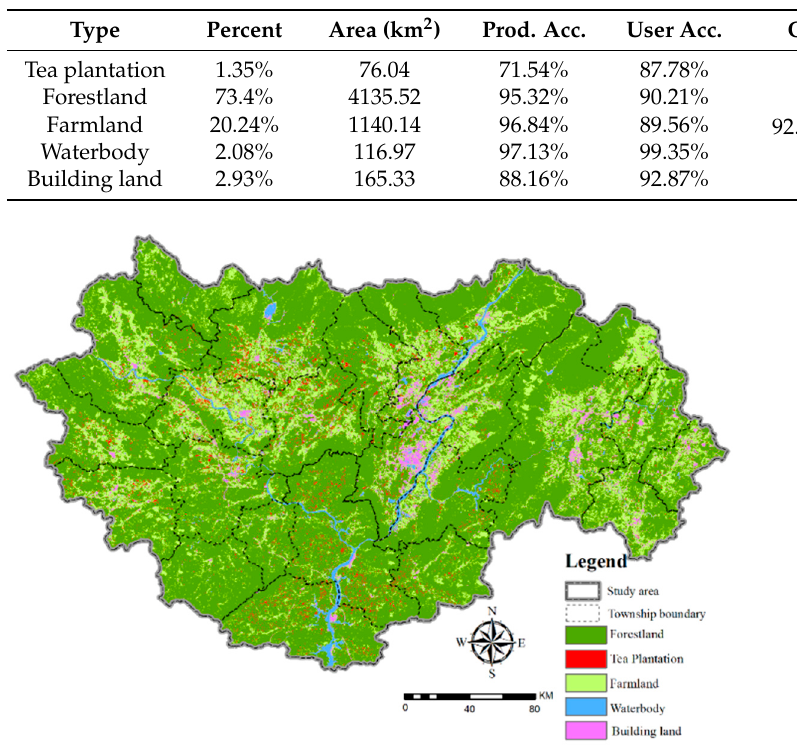
Figure 3. Land use classification in the study area. Table 5. Accuracy evaluation of land use classification in the study area .